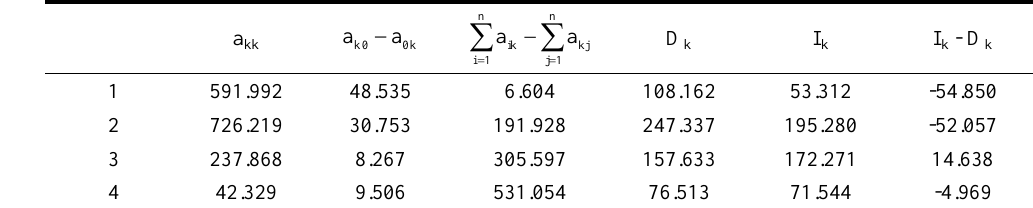
Table 4 Information of lake dynamic evolution from 2000 to 2014 (Unit: km 2 )